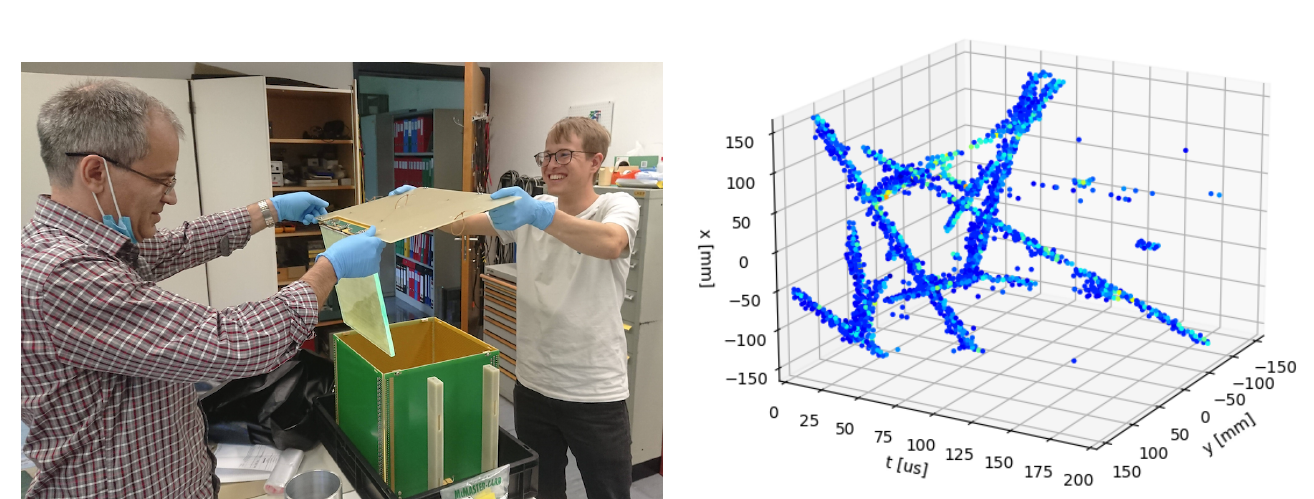
Figure 15. ( Left ) Installation of a LArPix tile and ArCLight panel assembly into the SingleCube TPC at the Univ. of Bern. ( Right ) An overlay of the raw data from 25 typical cosmic ray events collected during the first SingleCube operation run in October 2020.